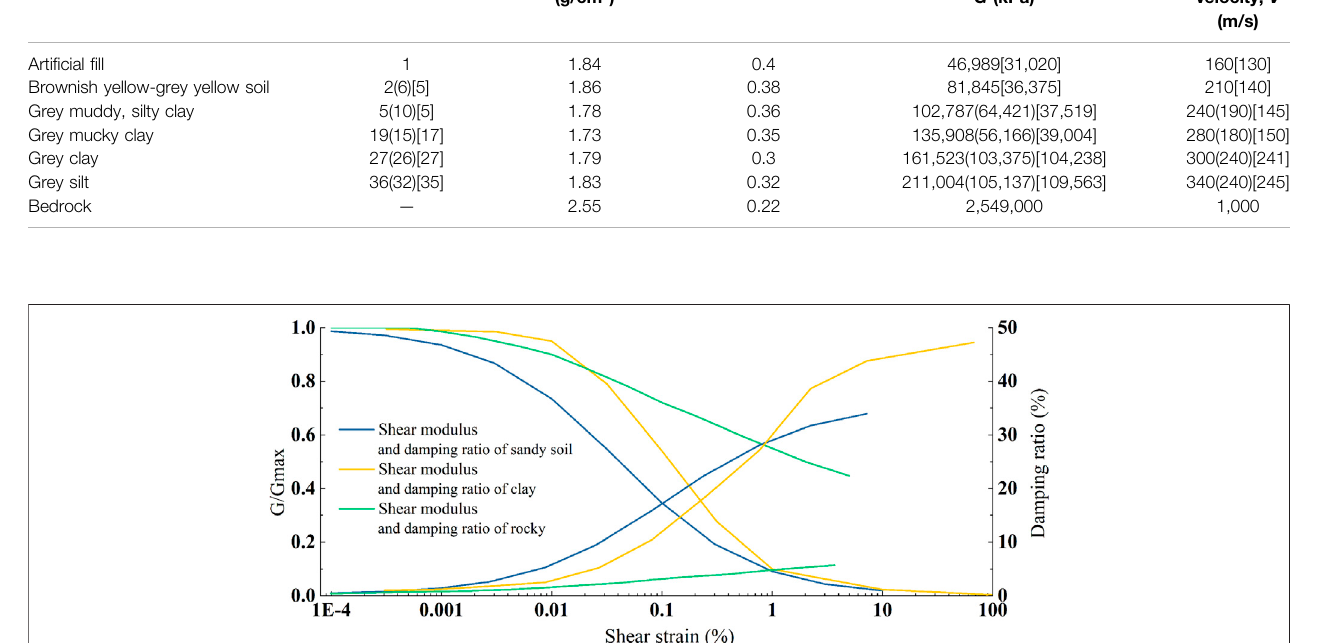
Frontiers in Earth Science |